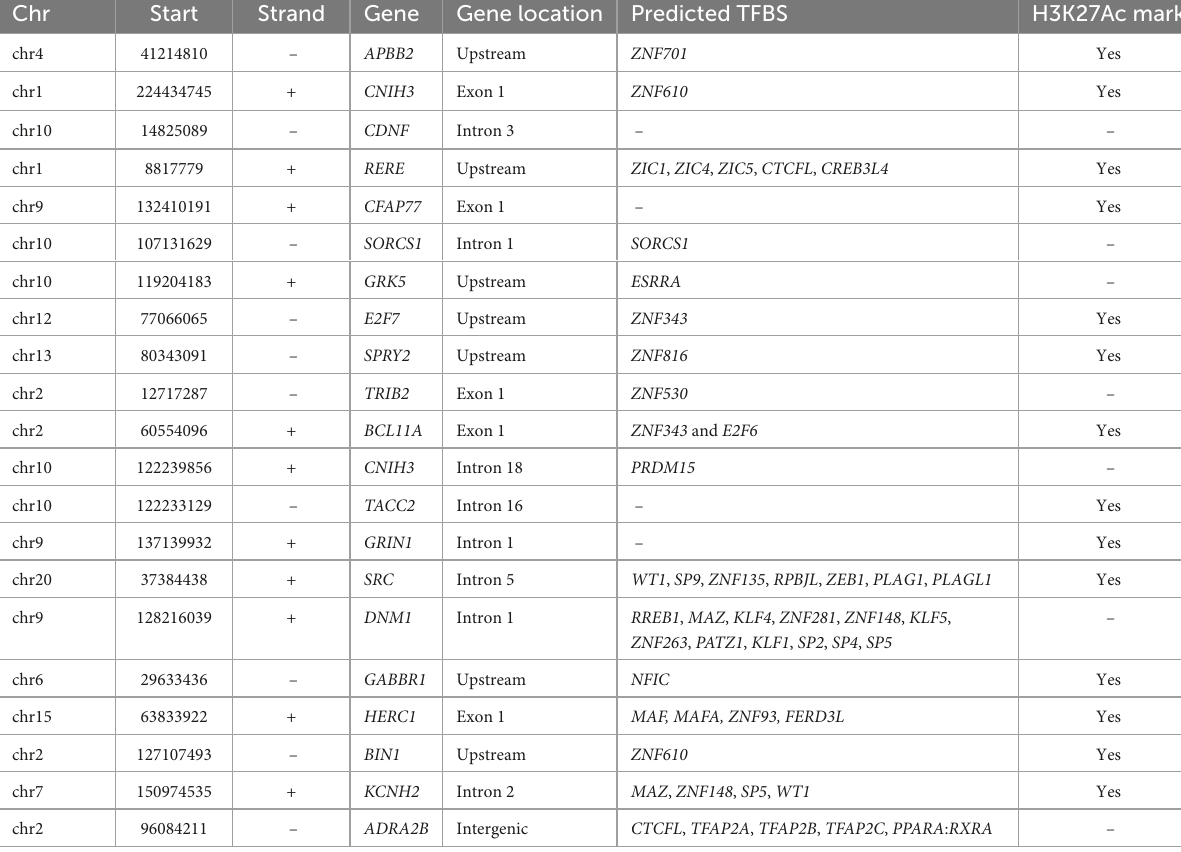
TABLE 3 Detailed information about transcription factor binding site (TBFS) and H3K27Ac